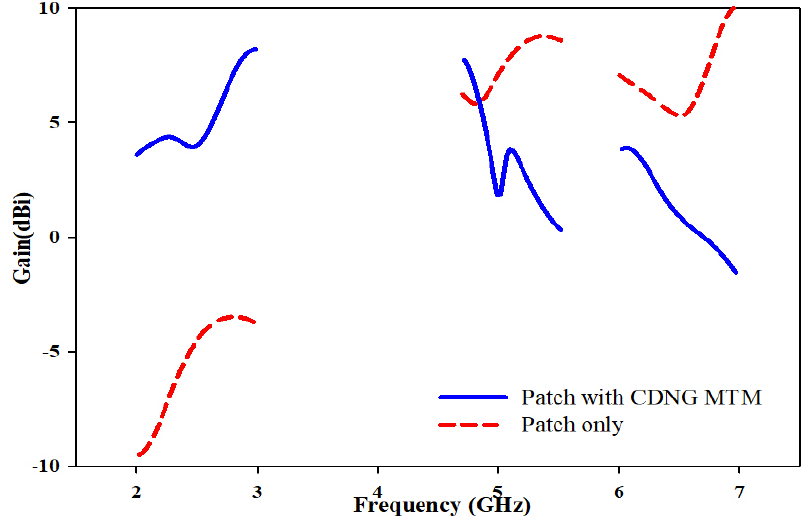
Figure 8. Gain plot of the proposed antenna with and without CDNG-MTM.